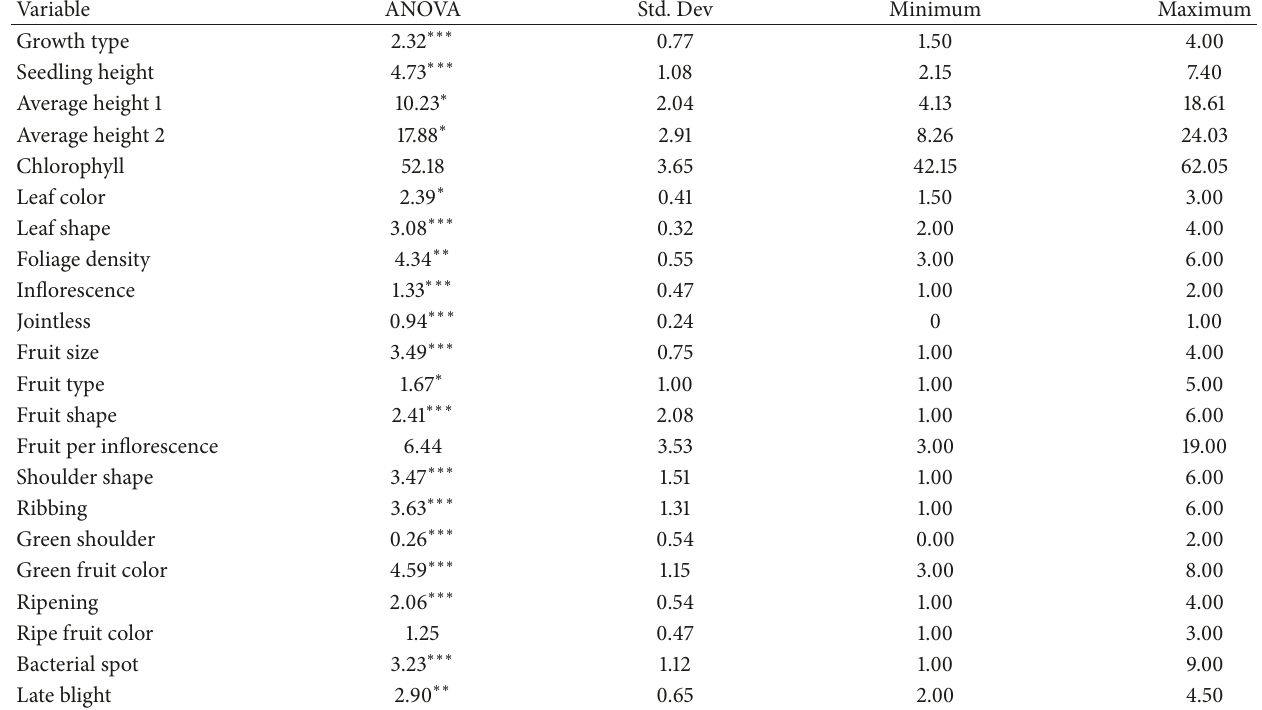
Table 3: Analysis of variance (ANOVA), standard deviation (Std. Dev), and minimum and maximum scores of ninety-one fresh-market tomato genotypes for respective morphological traits measured.